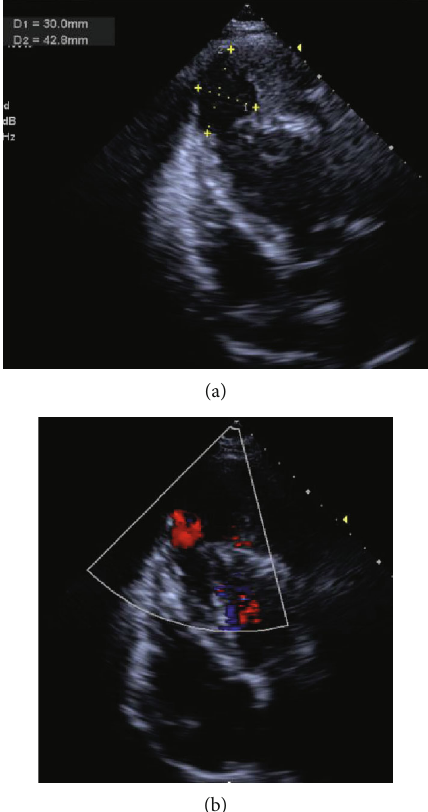
Figure 2: Four-chamber view TTE: the pseudoaneurysm did not change in the size (a) and active bloodstream to the pseudoaneurysm on color Doppler